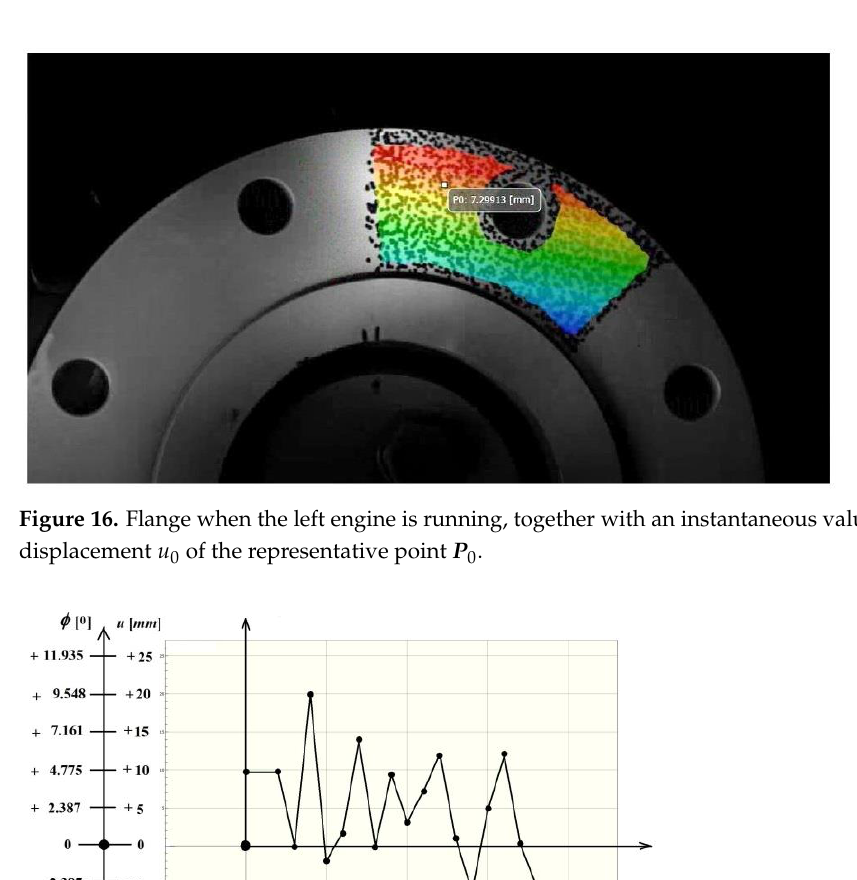
Figure 17. Diagram of variation of the linear displacement 0 u corresponding to the representative P and of the corresponding torsion angle  , for the case of the solitary operation of the point 0 left engine.